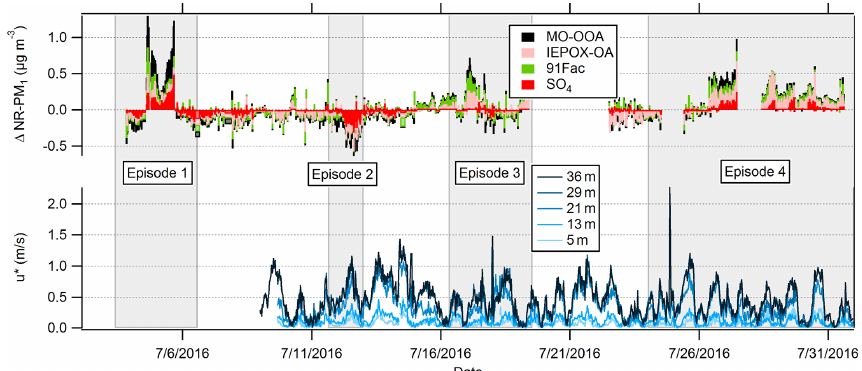
Figure 5. Time series of (top) observed NR-PM 1 vertical differences between above- and below-canopy inlets and (bottom) friction velocity ( u ∗ ) in ms − 1 at five different heights on the PROPHET tower. Vertical differences are defined as (cid:49) species, where (cid:49) refers to the above- canopy minus the below-canopy mass concentration. Note that the elevations for u ∗ are slightly different than those for trace gas sampling. The date format is month/day/year.